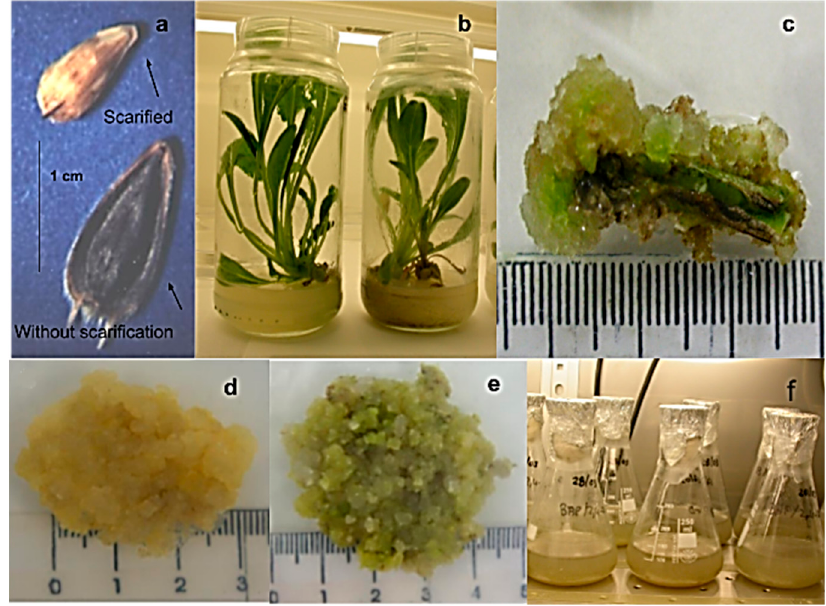
Figure 2. Seeds and cell cultures of Helianthella quinquenervis : ( a ) seeds with and without scarification; ( b ) two months in vitro plants; ( c ) leaf explant with forming callus; ( d ) callus in darkness; ( e ) callus in photoperiod; ( f ) cell suspension culture.